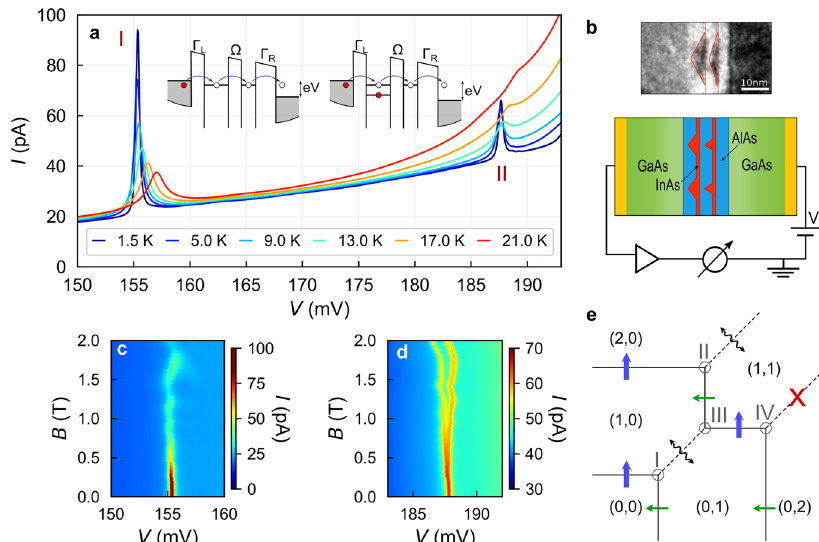
Fig. 1 Experiment. a Current-voltage characteristic of InAs double quantum dots (DQDs) for different temperatures between 1.5 and 21 K. The inset shows simpli fi ed energy level diagrams of the DQD system: the left diagram for the fi rst resonance peak (peak I) around 155 mV and the right diagram for the second resonance peak (peak II) around 188 mV. b Transmission electron microscope image of a DQD device of similar layer structure and schematic image of the investigated heterostructure and the measurement setup, see methods section for detailed information. c Current of resonance I as function of voltage and magnetic fi eld at T = 1.5 K. d Same for resonance II. e Charging diagram of the double quantum-dot system with all the triple points involving one and two-electron states. The different couplings to the two leads are depicted by arrows with different colors and thicknesses.